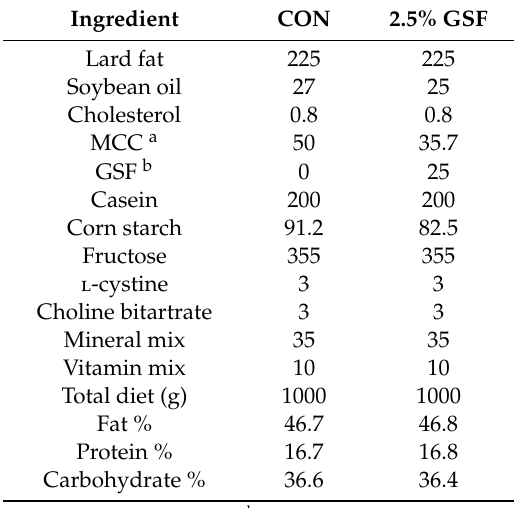
Table 1. Animal diet